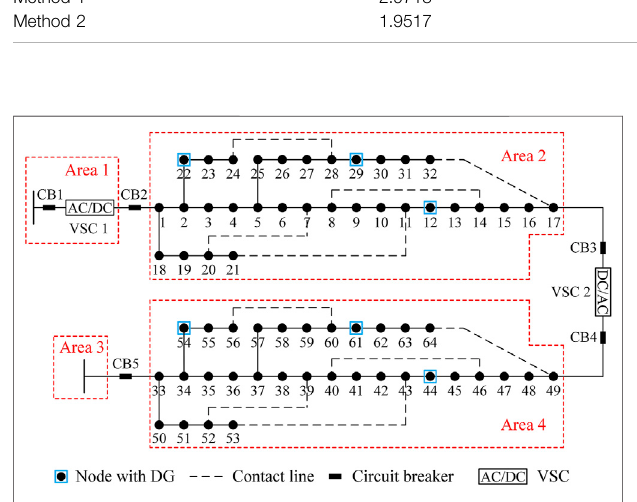
FIGURE 3 | Schematic diagram of area division in the AC/DC hybrid distribution